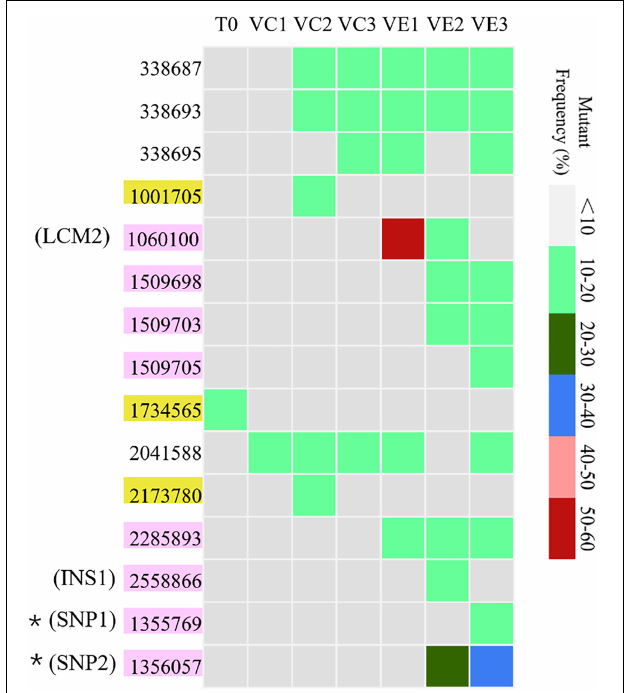
FIGURE 5 | The distribution and the mutation frequencies of SNVs and InDels in evolved and coevolved V. alginolyticus cell populations revealed by resequencing. T0: the collected sample before grouping at the early exponential stage ( OD 600 nm = 0.6–1); VC1: collected samples from evolved cell populations at 2 h; VC2: collected samples from evolved cell populations at 13 h; VC3: collected samples from evolved cell populations at 22 h; VE1: collected samples from coevolved cell populations at 2 h; VE2: collected samples from coevolved cell populations at 13 h; VE3: collected samples from coevolved cell populations at 22 h. Mutation sites with yellow background represent 2 unique SNVs in the evolved cell populations. Positions of mutation sites with purple background represent 8 unique mutations in the coevolved cell populations. Mutation frequencies of these sites are shown with different